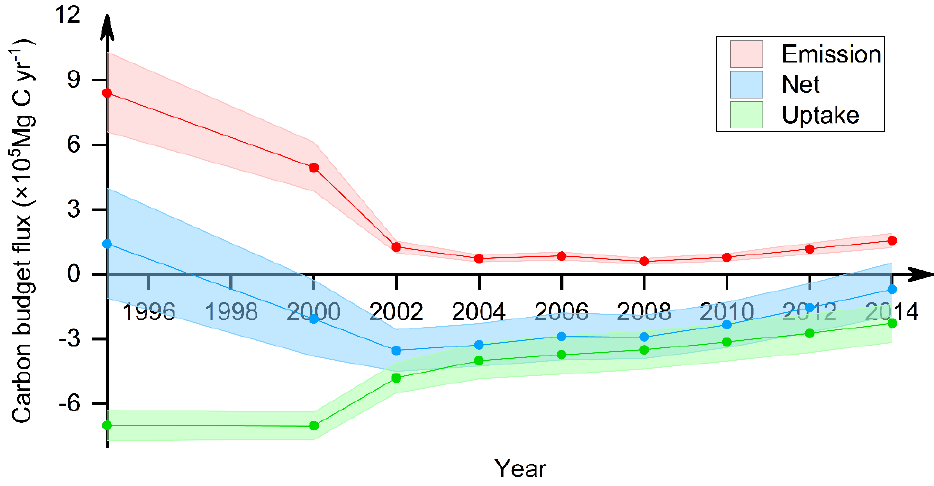
Figure 7. Carbon flux with 95% confidence intervals for Guangzhou over 1995 – 2014.